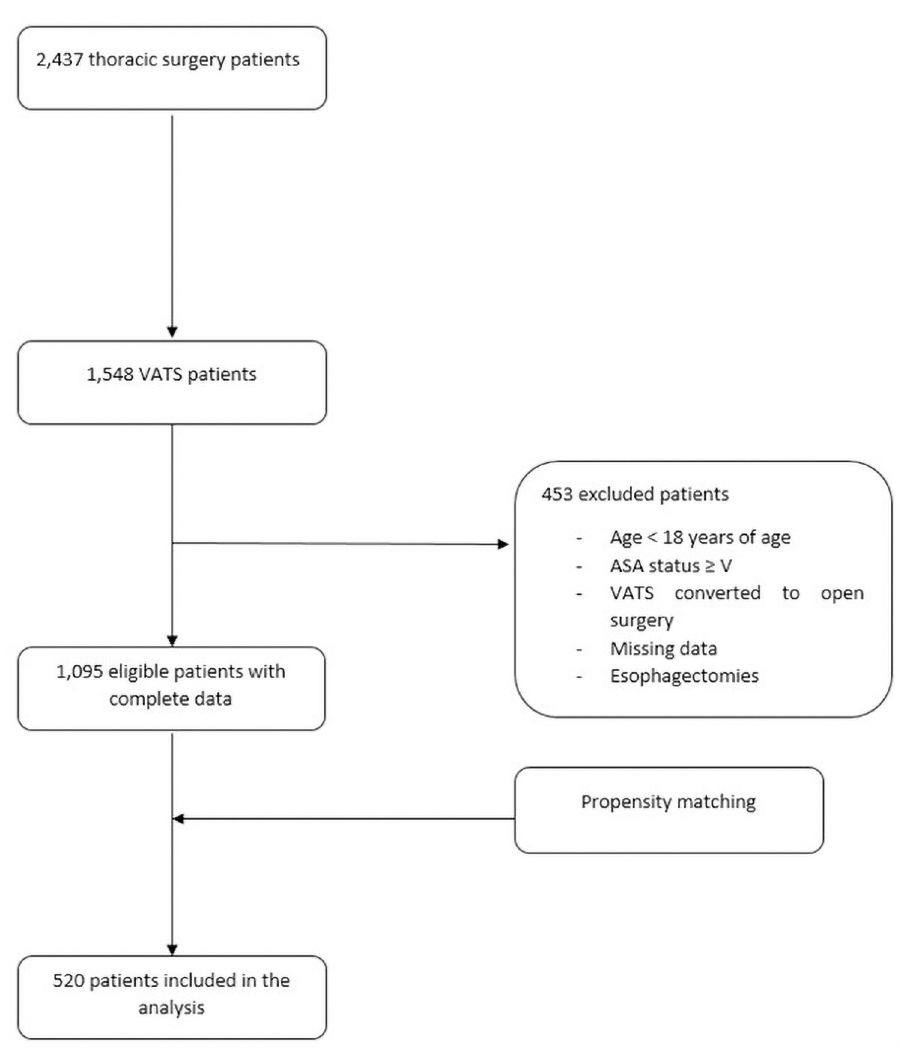
Fig 1. Flow chart of patient